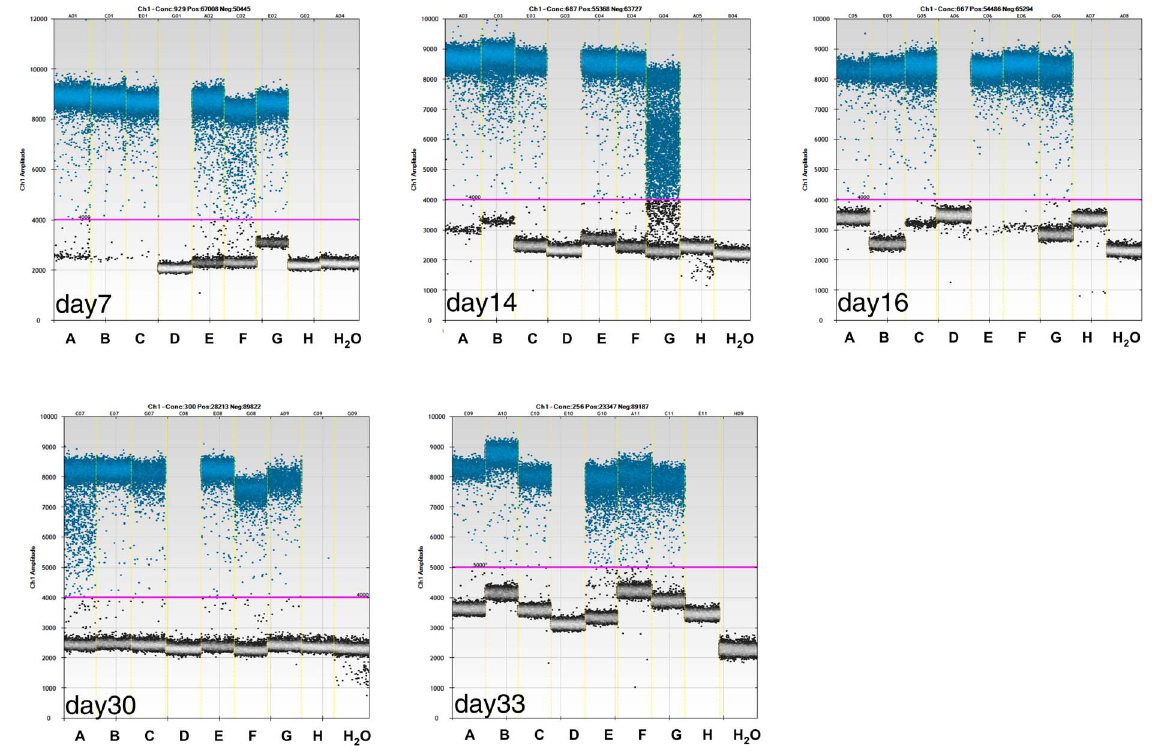
Figure 1. IGF1 transgene detection by ddPCR. Eight mice, 6 AAV9-IGF1 muscle transduced (A, B, C, E, F, G) and two controls (D and H) were screened for 33 days by ddPCR for IGF1 transgene detectability.